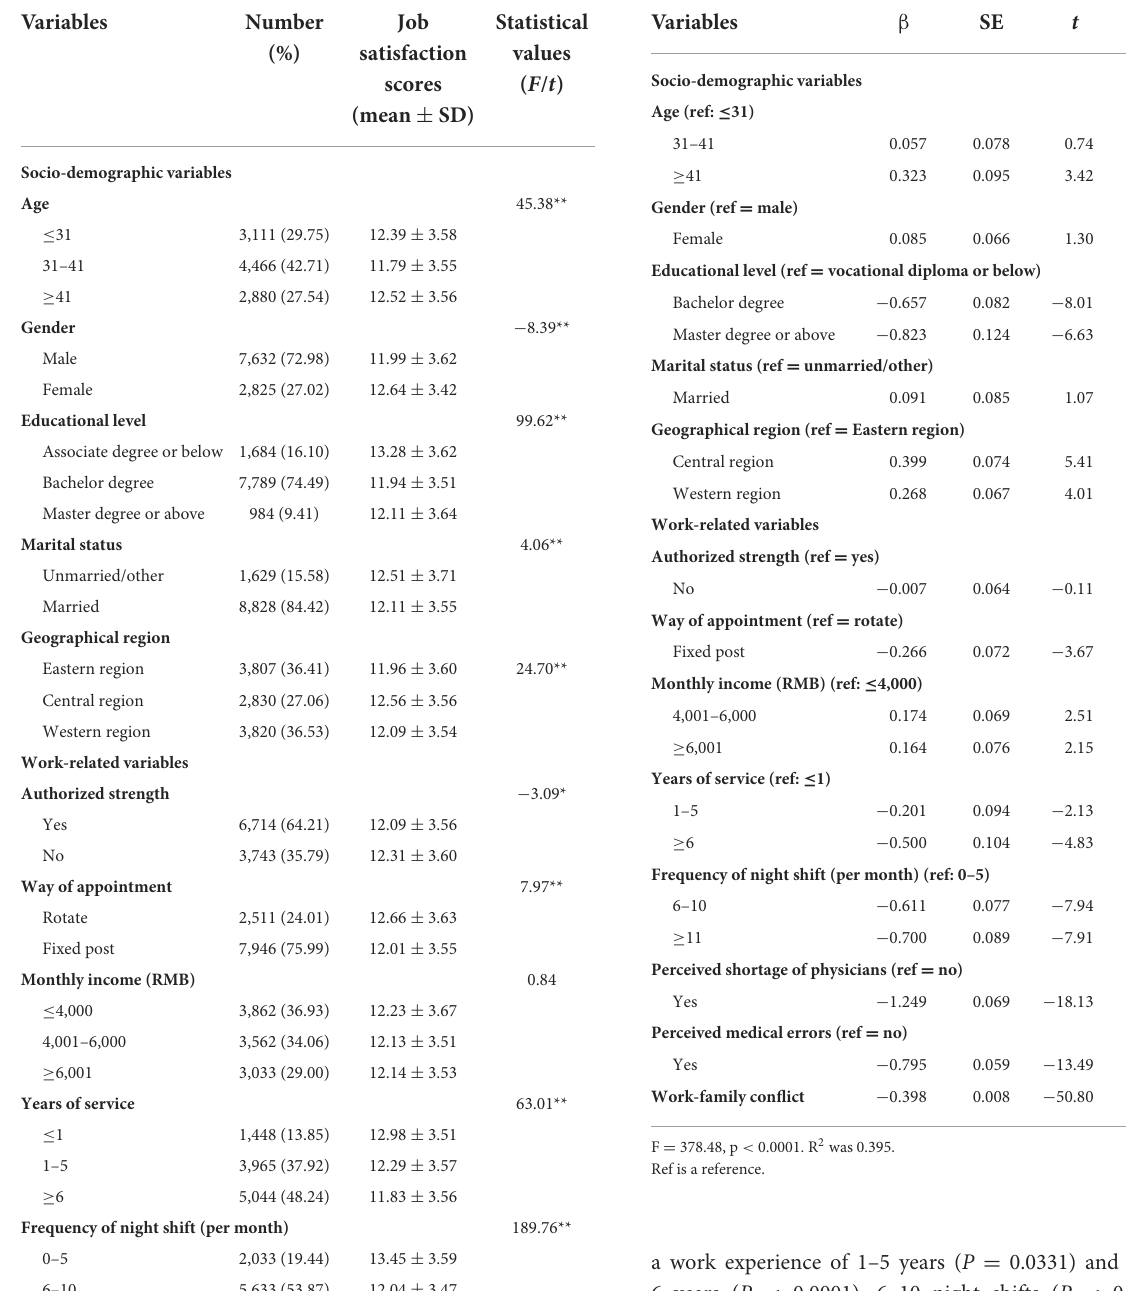
TABLE 1 Univariate analysis of job satisfaction of emergency department physicians ( n = 10,457).